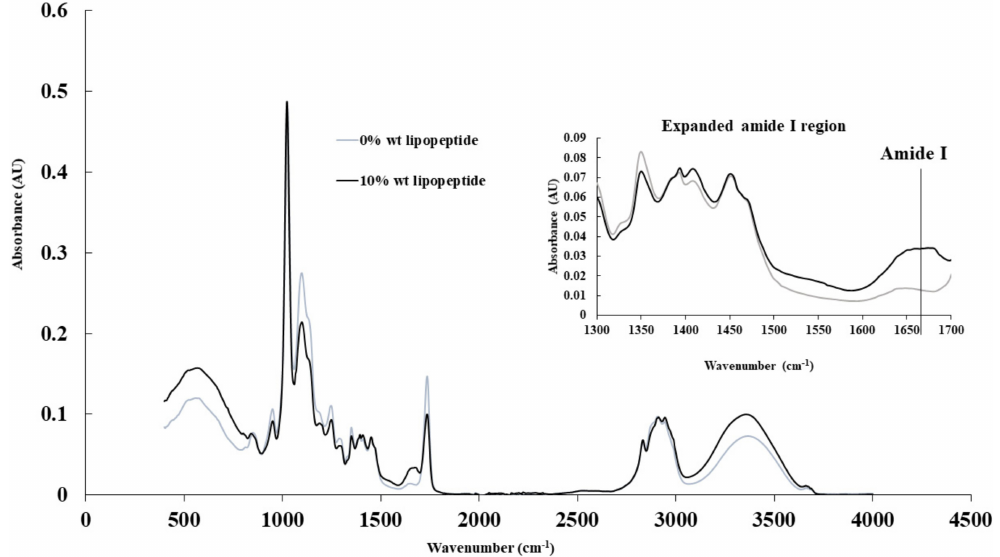
Figure 2. Full FT-IR spectrum of the PEG hydrogel prepared in methanol in the absence and presence of the